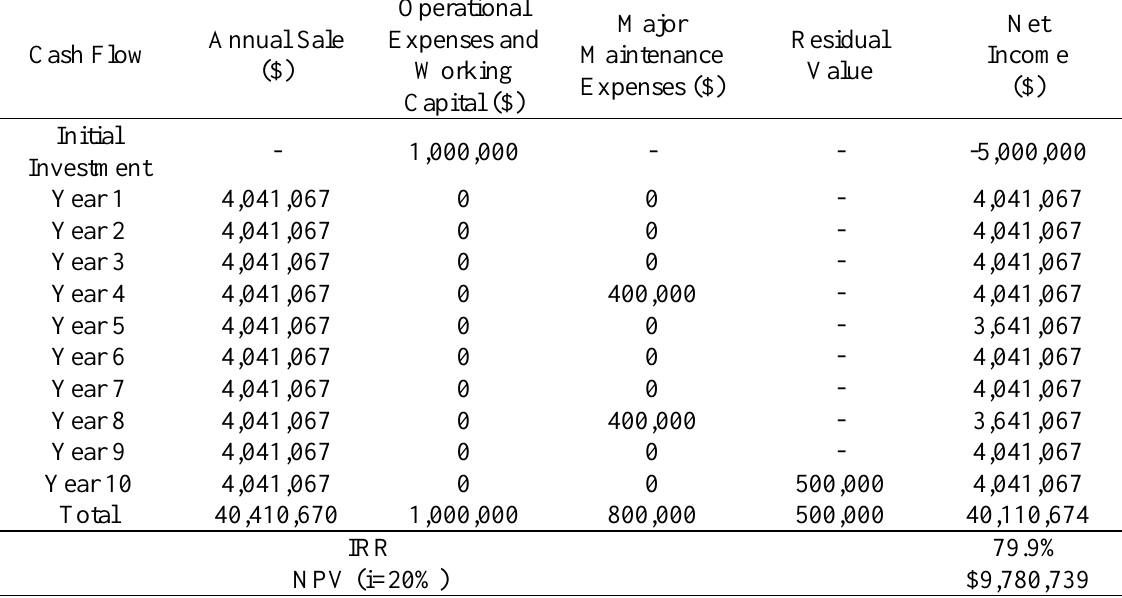
Table 8 . The Financial Process of SRF utilization in Kerman's cement